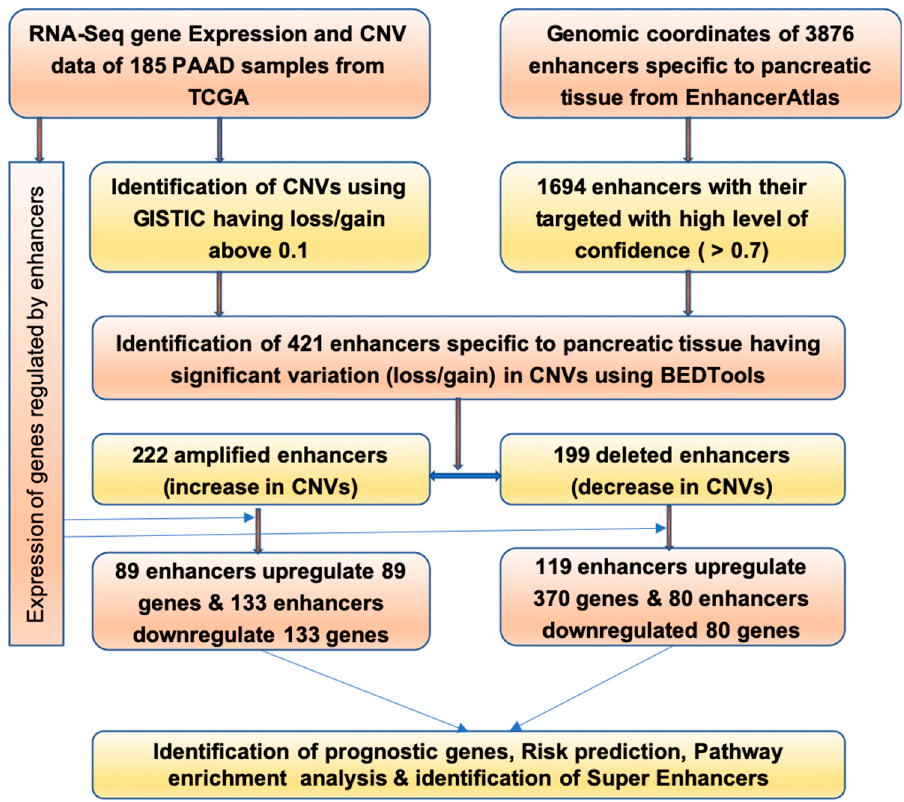
Figure 5. Computational workflow of the study.